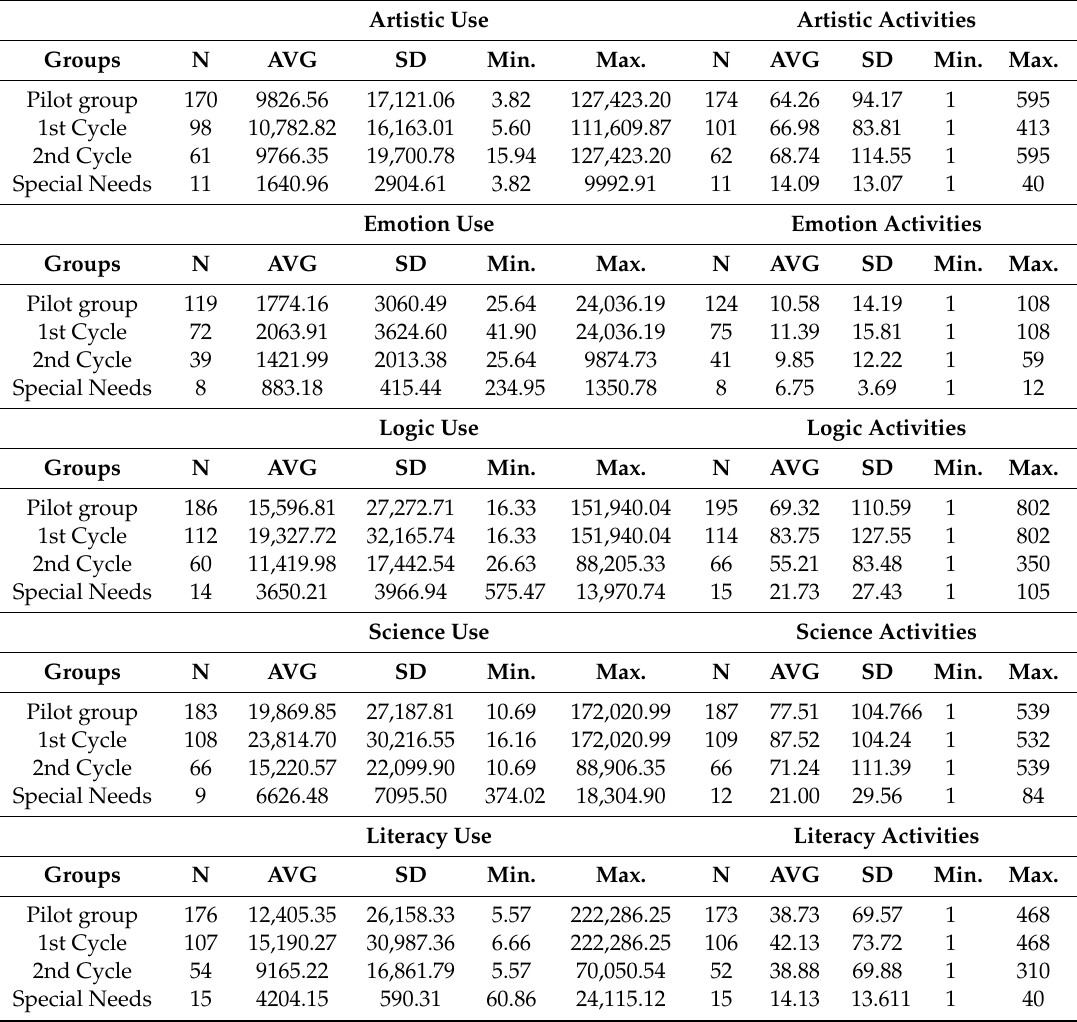
Table A1. Descriptive statistic of the Pilot Group 1 at platform worlds. The use is measured in seconds and the activities done are collected as